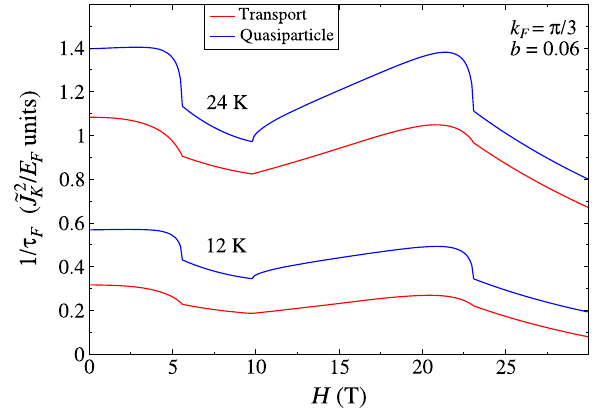
FIG. 15. Transport and quasiparticle relaxation rates from Eqs. (37) – (39) and their quasiparticle analogues vs field for representative temperatures, b ¼ 0 . 06 , and k parameters are from Table I. Transport rates are from Fig. 10(a).